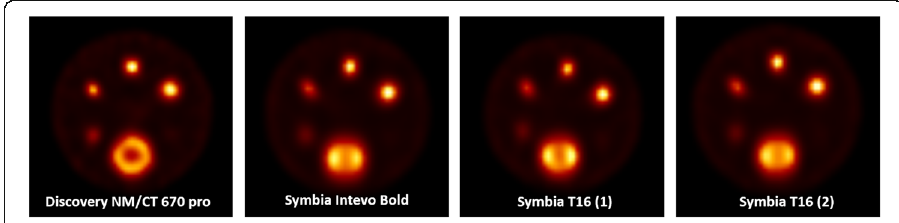
Fig. 4 SPECT images of the cylindrical phantom for all systems, reconstructed with a vendor-neutral